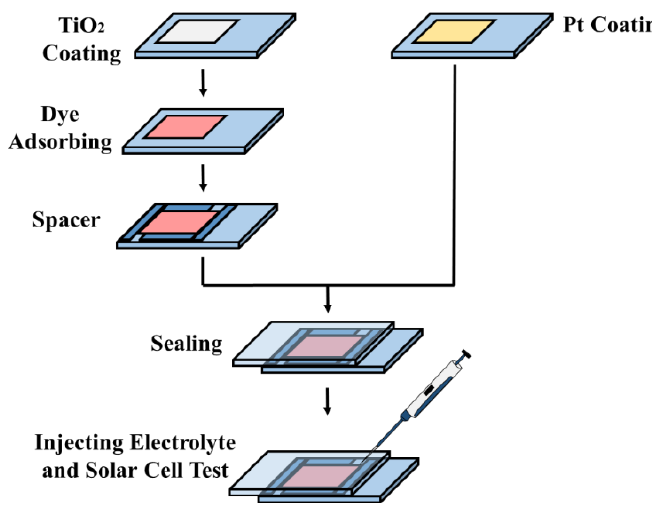
Figure 2. Dye-sensitized solar cells (DSSC) assembly.